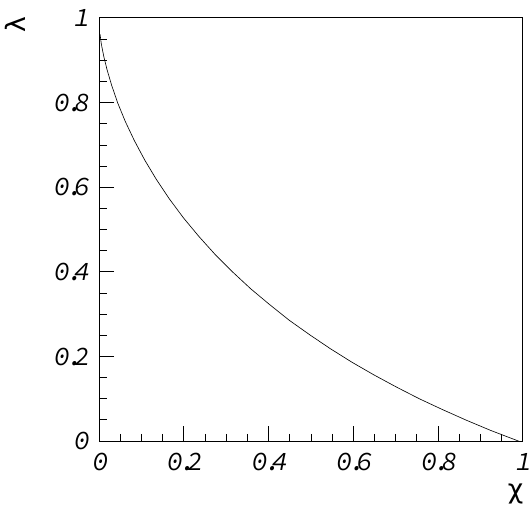
FIG. 2. The l factor according to Eq.